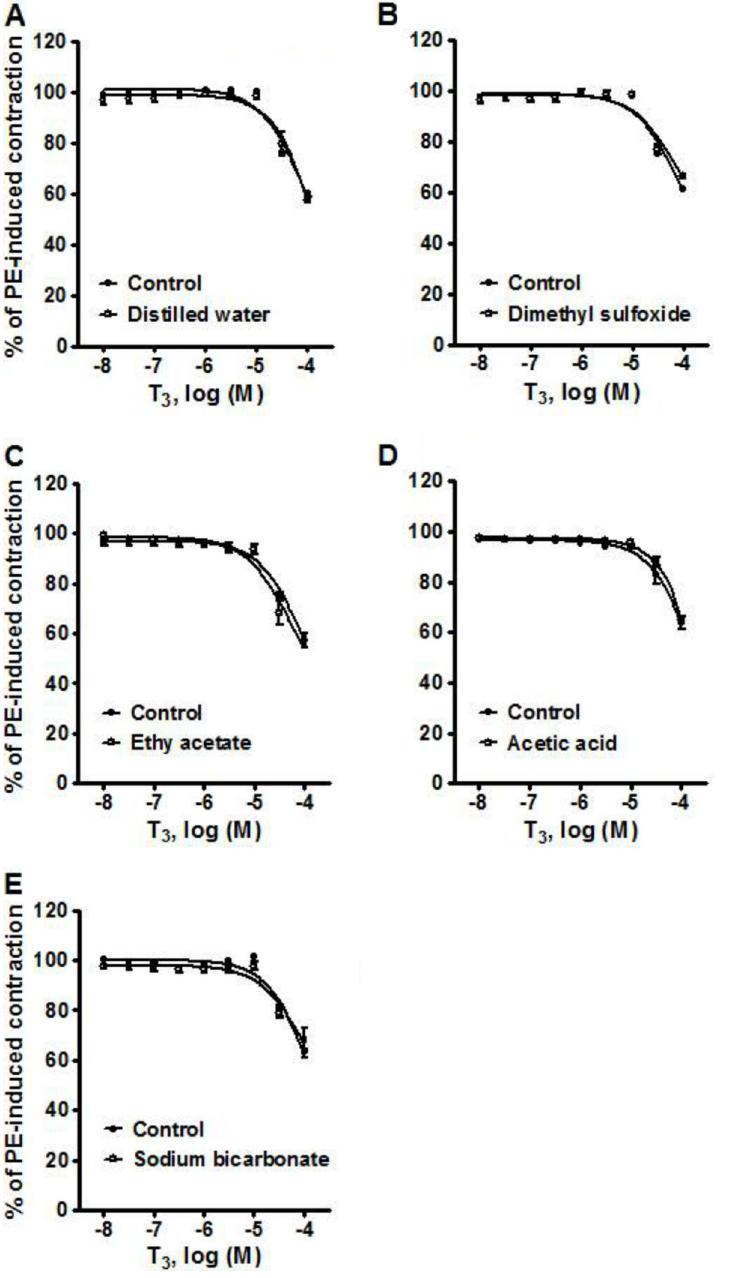
Figure 6. Vasorelaxation produced by 10 -8 – 10 -4 M T 3 in phenylephrine (PE)-precontracted rat aortic rings. Assays were carried out to test the effect of: A : distilled water, B , 1.39 (cid:1) 10 -2 M dimethyl sulfoxide, C , 1.01 (cid:1) 10 -2 M ethyl acetate, D , 1.73 (cid:1) 10 -2 M acetic acid, and E , 9.4 (cid:1) 10 -5 M sodium bicarbonate. Data are reported as means ± SE